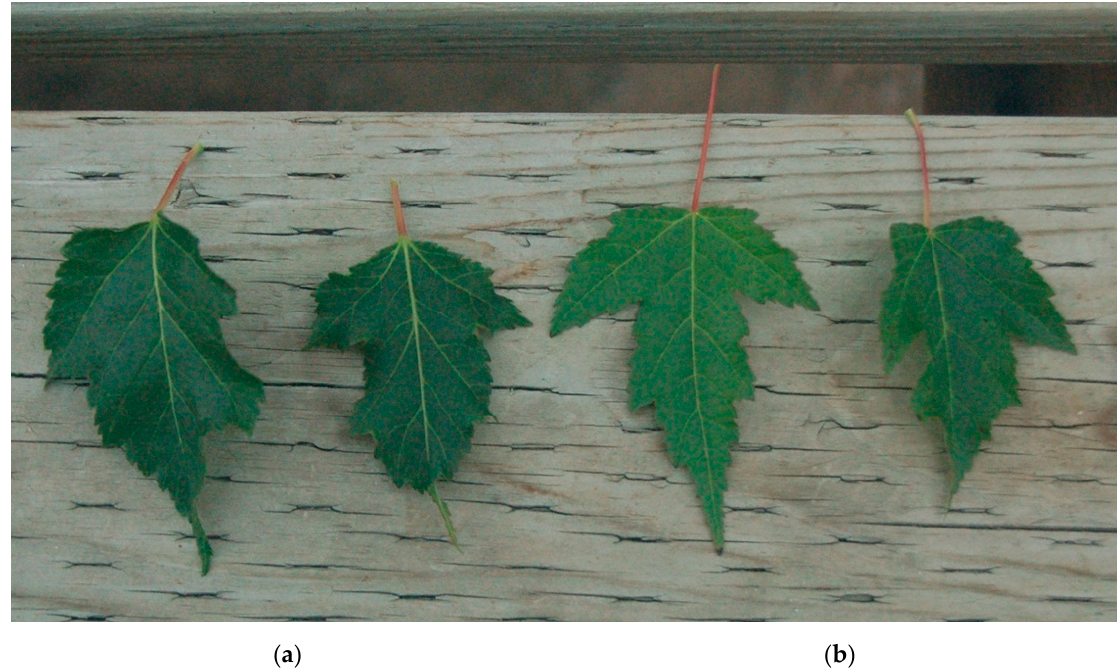
Figure 5. Two leaves of tetraploid ( a ) and two leaves of diploid ( b ) forms of Acer tataricum ssp. ginnala .